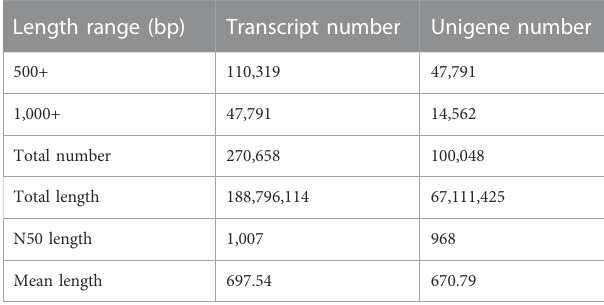
TABLE 1 Summary of the transcriptome assembly of S. frugiperda